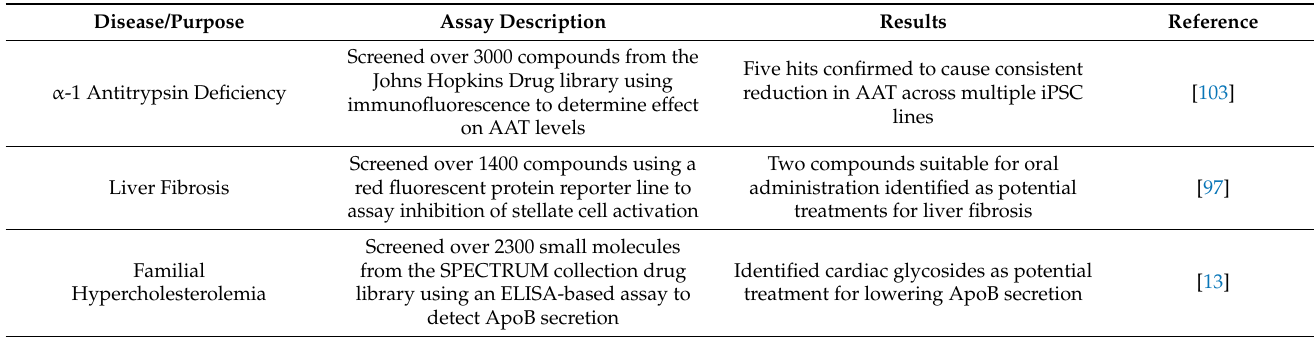
Table 2. High-Throughput Drug Discovery and Development Assays Using iPSC-based